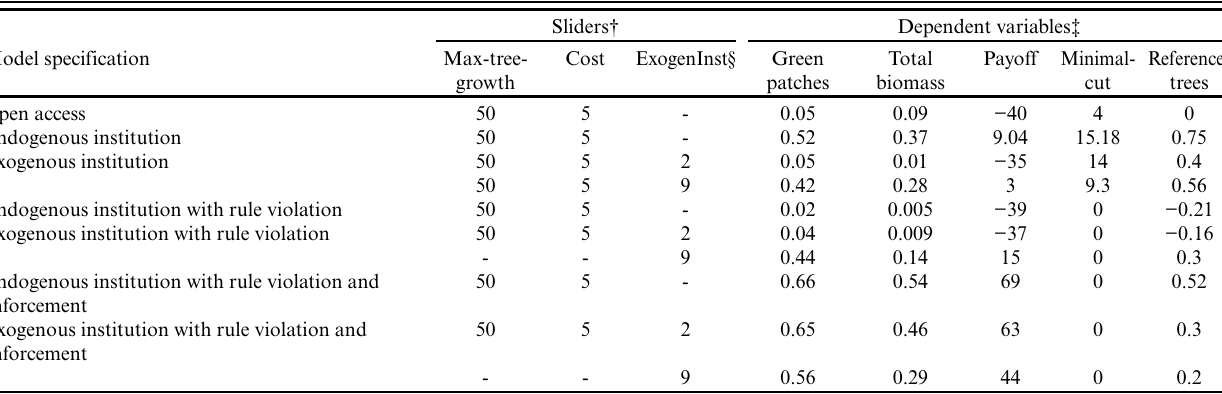
Table 2. Summary of simulation results for the seven different model specifications. Each specification of the model was run